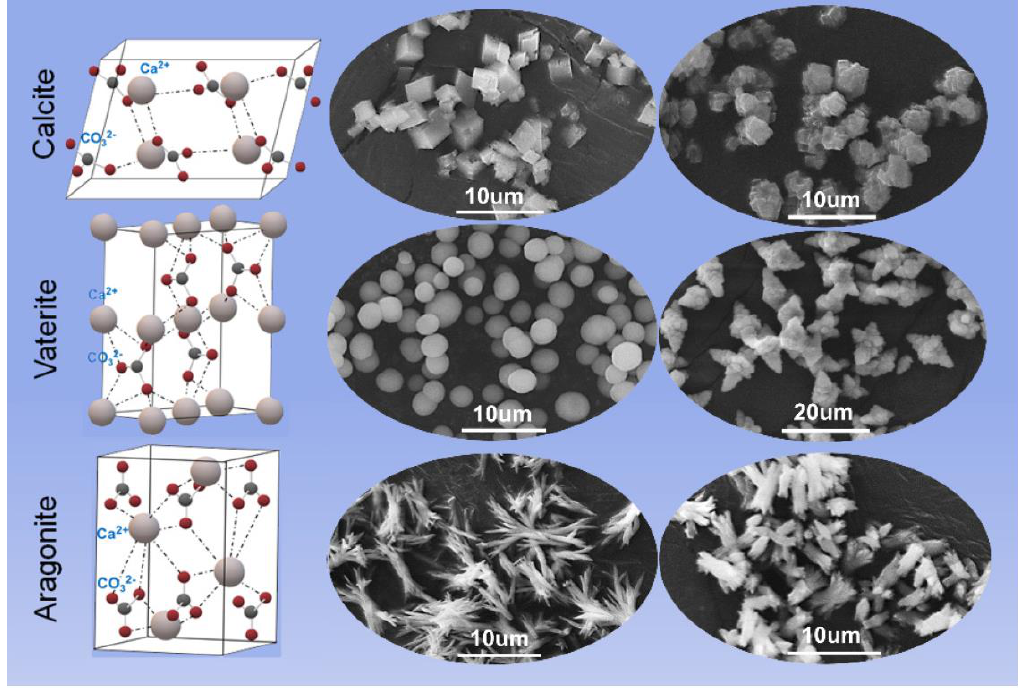
Figure 1. Crystal structure and morphology of three polymorphs of CaCO 3 , reproduced from [18], 2022, MDPI.